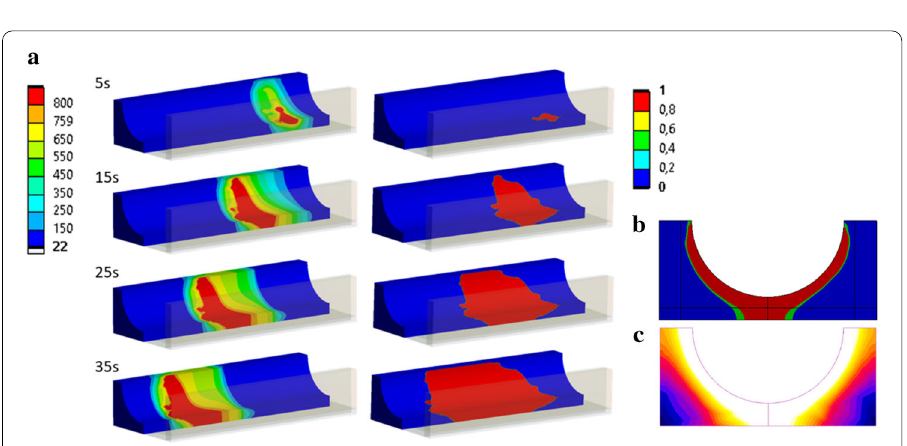
Fig. 13 Temperature evolution (left) and formation of austenitic phase (right) during scanning induction hardening of the pitch